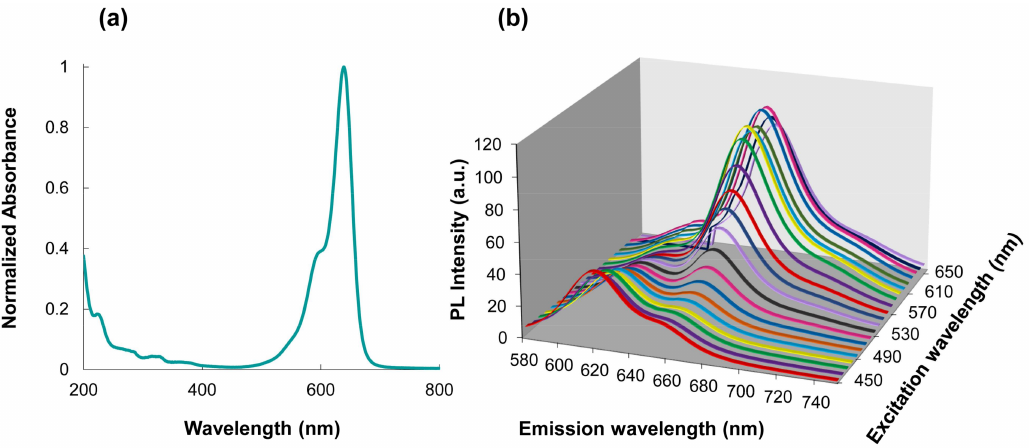
Figure 5. ( a ) Absorption spectrum of the Cy5 dye and ( b ) the MPA-capped CdTeSe-Cy5 conjugate 3D spectra.